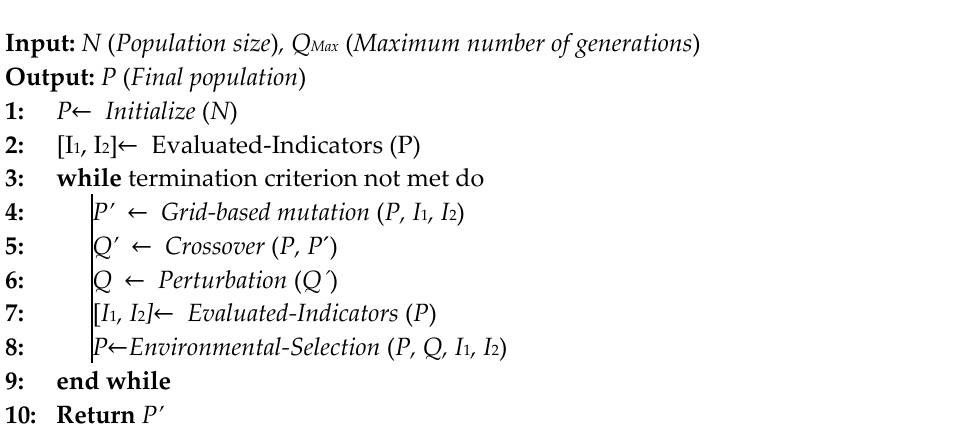
Algorithm 1: General framework of ad-GrMODE